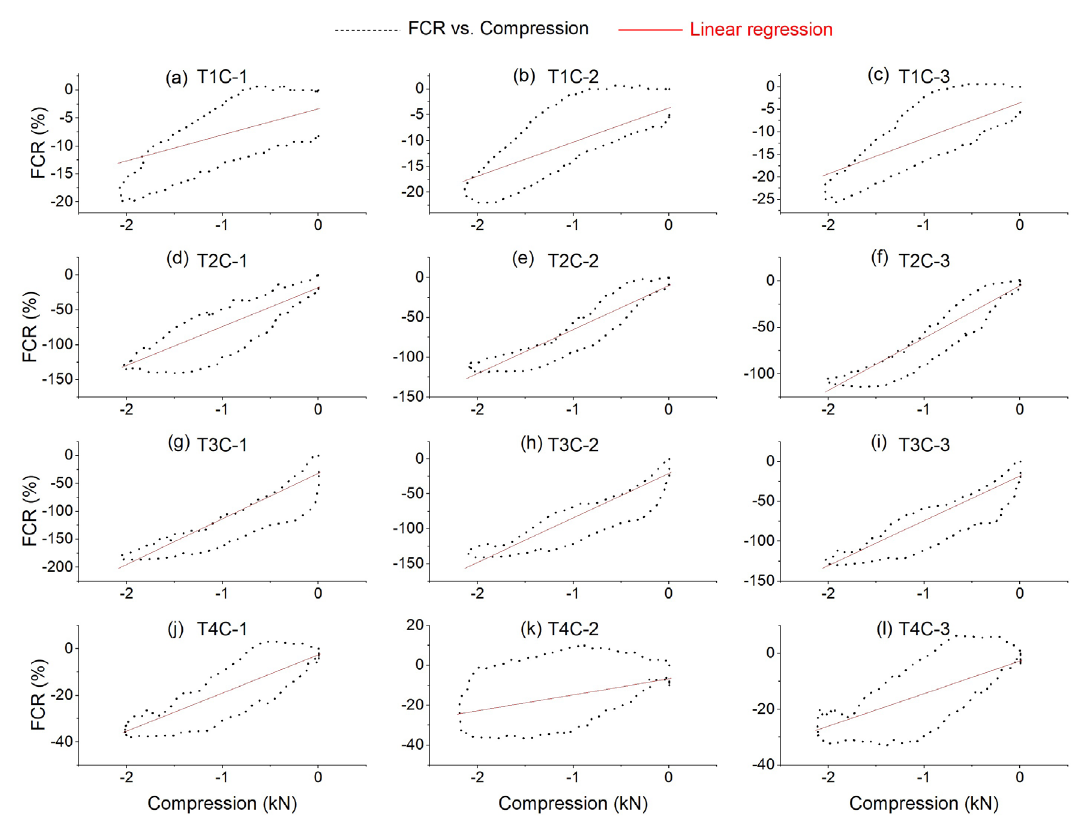
Figure 10. Graphical relationship between FCR and compression force, with linear regression (line in red) in each mix and repetition test for T1C (a, b, c), T2C (d, e, f), T3C (g, h, i) and T4C (j, k, l).